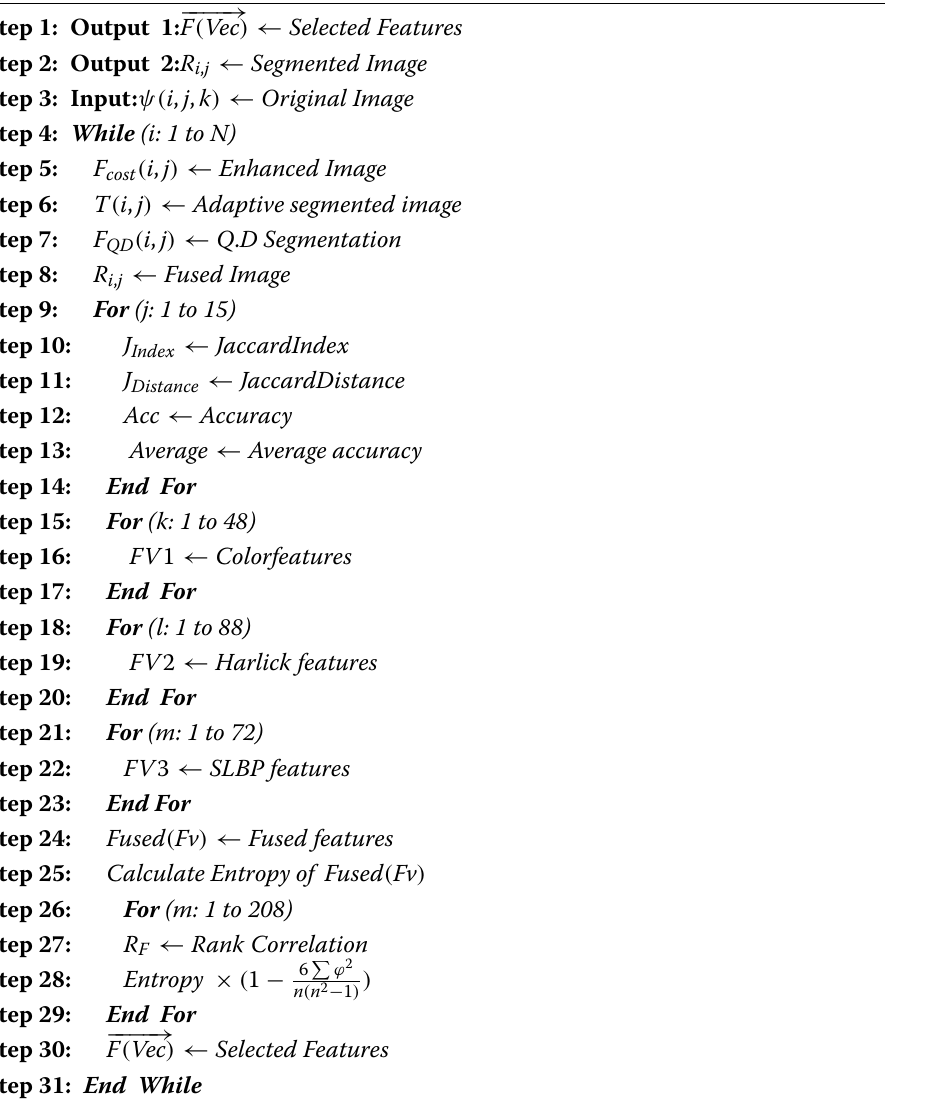
Algorithm 1 Detection and Classification of Fruit